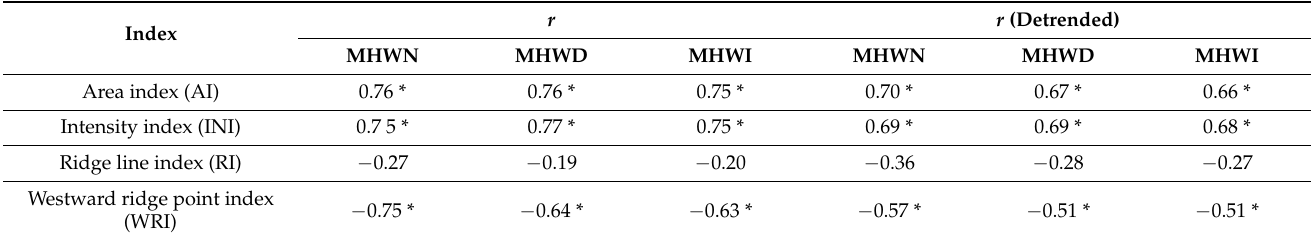
Table 2. Correlation coefficients ( r ) between the WNPSH indices and the MHW indices temporal series from 1982 to 2020, with and without detrending.